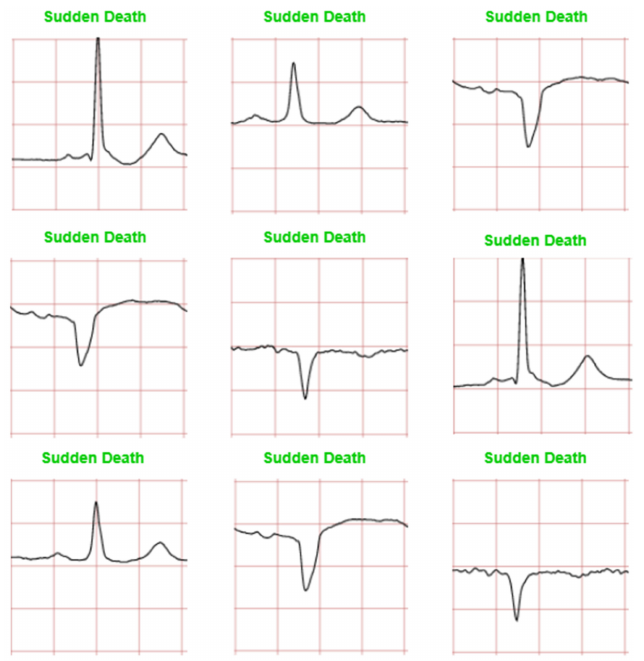
Figure 12. Prediction for ‘sudden death’ ECG waveforms. (Note: red and green title indicated incorrect and correct prediction,